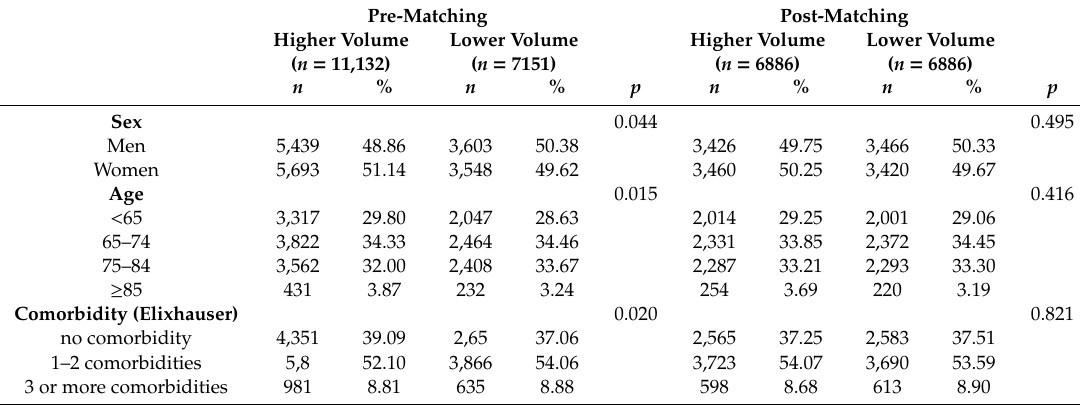
Table 1. Characteristics of the total hip arthroplasty study population prior to and after matching. RACat